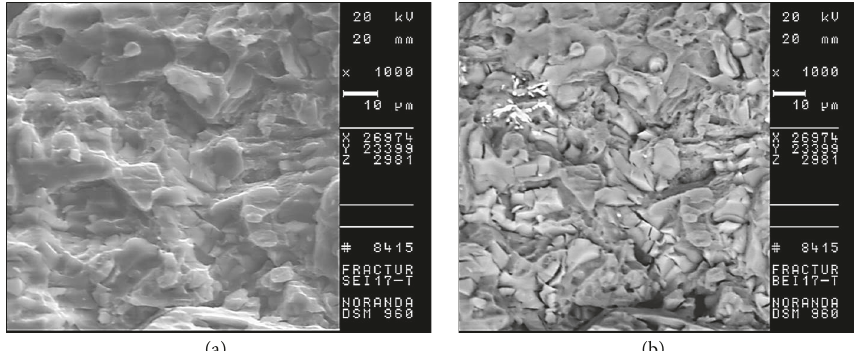
Figure 10: (a) Secondary electron image of the D alloy, 11wt% Al; (b) backscattered electron image of (a).